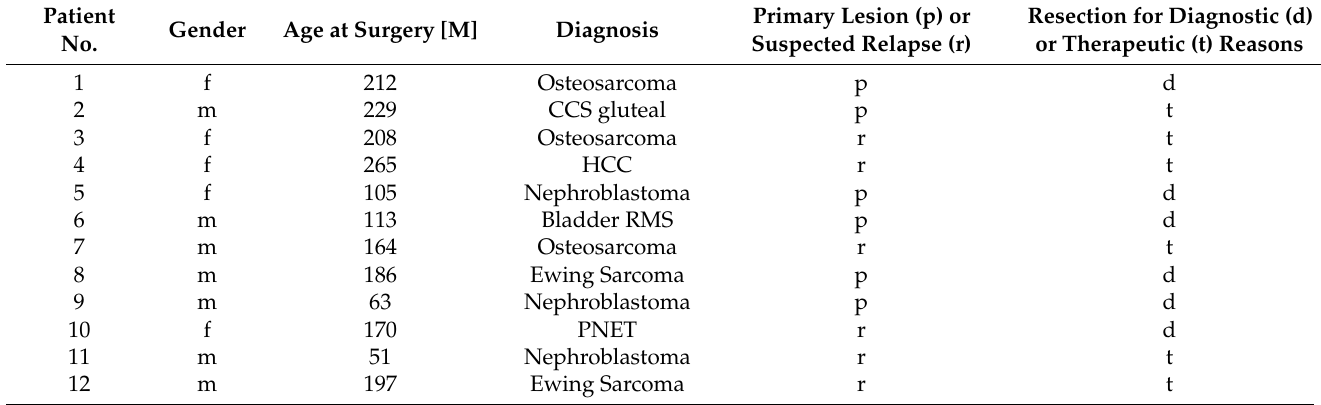
Table 1. Patients’